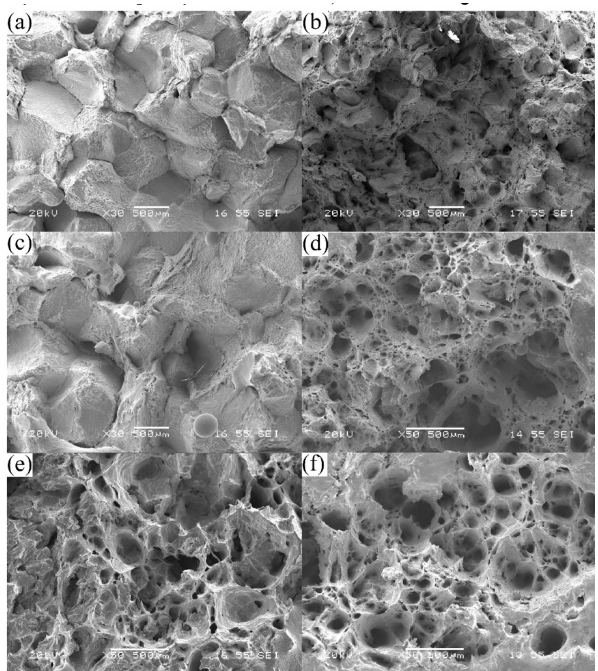
Figure 6: Fracture morphology of tensile-tested samples: (a) alloy 1 at 1000°C, (b) alloy 2 at 1000°C, (c) alloy 1 at 1050°C, (d) alloy 2 at 1050°C, (e) alloy 1 at 1100°C, (f) alloy 2 at